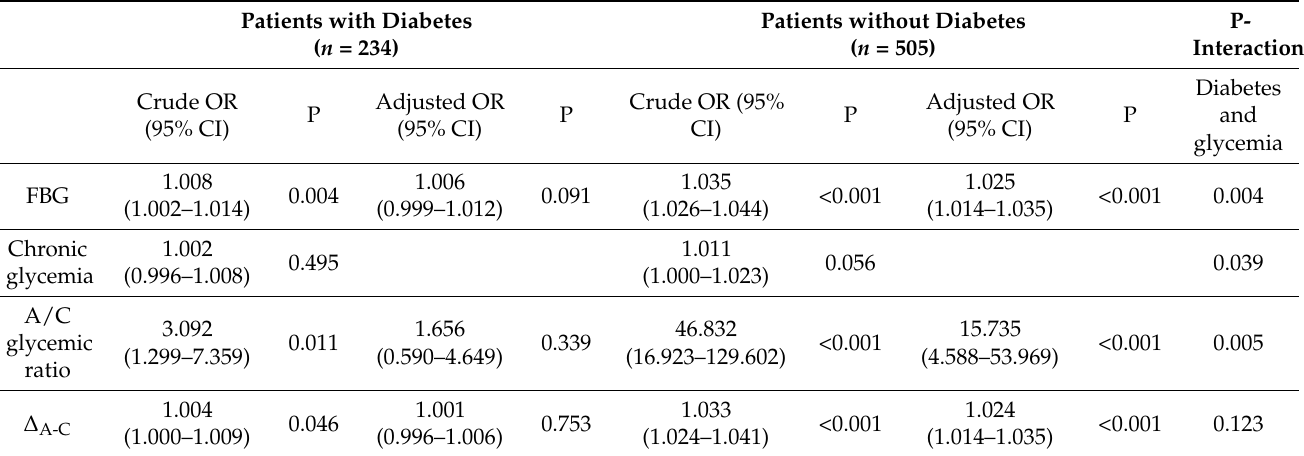
Table 3. Subgroup analysis of glycemia for poor functional outcome with patients with or without